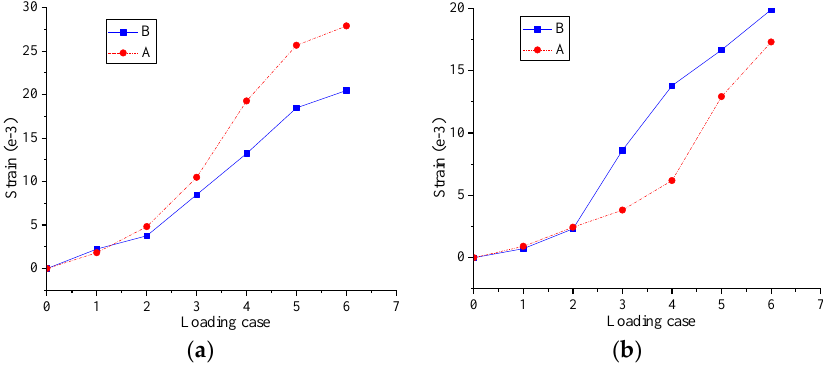
Figure 8. The damage of second floor slab around the impacted column at the end of case G6. ( a ) Model A; and ( b ) Model B.